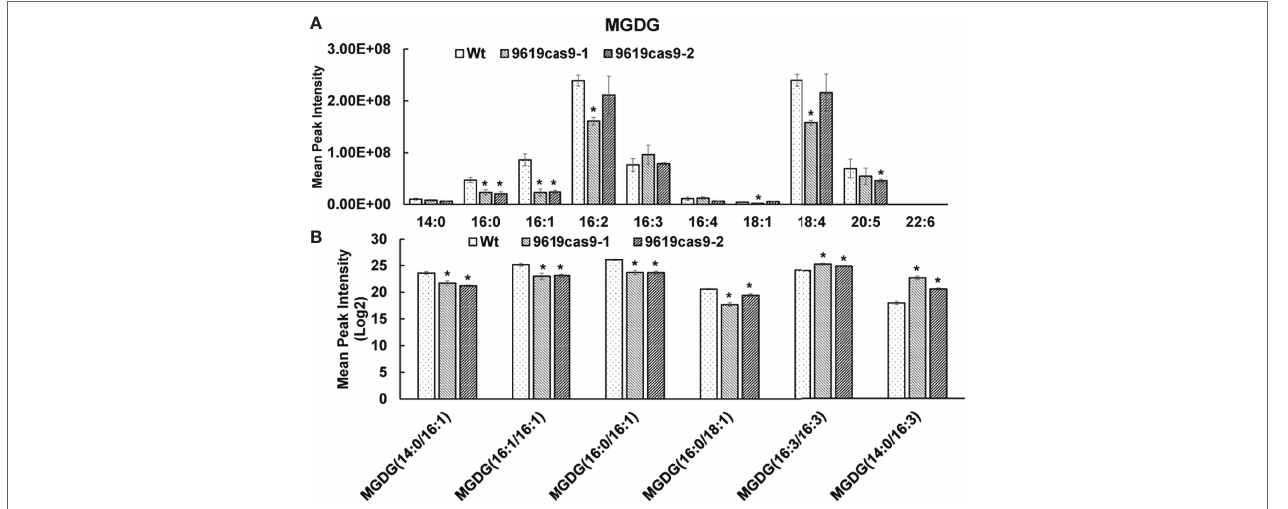
FIGURE 7 | Analysis of the distribution of fatty acids (A) and the fatty acid profiles in the MGDG lipid classes among Wt and mutants (B) . All values represent means ± standard deviations of four biological repeats. Asterisk represents statistically significant differences between wild-type and mutants based on Student’s t test (* p < 0.05).